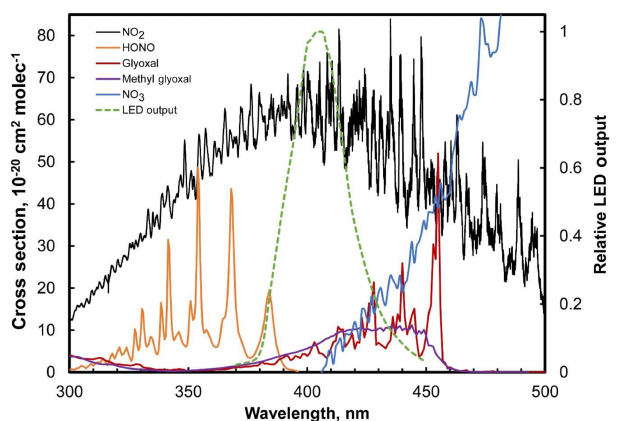
Figure 5. Absorption spectra of NO 2 and possible airborne interfer- ences (HONO, NO 3 , glyoxal, methyl glyoxal) along with the spec- tral output of the LED used in the model 405nm.